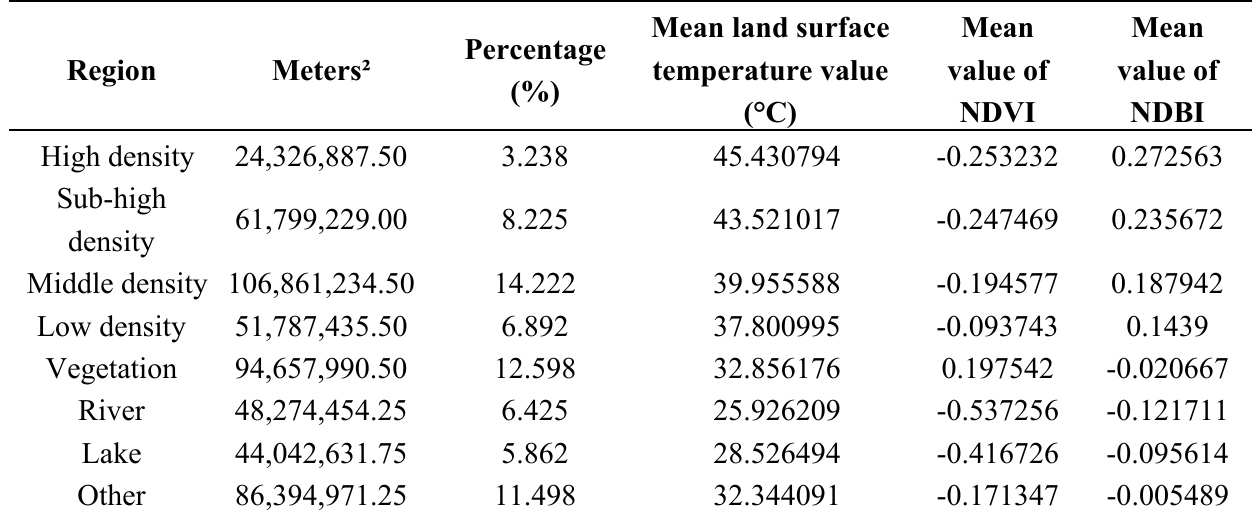
Table 2. Index of underlying surface of the small scale region of